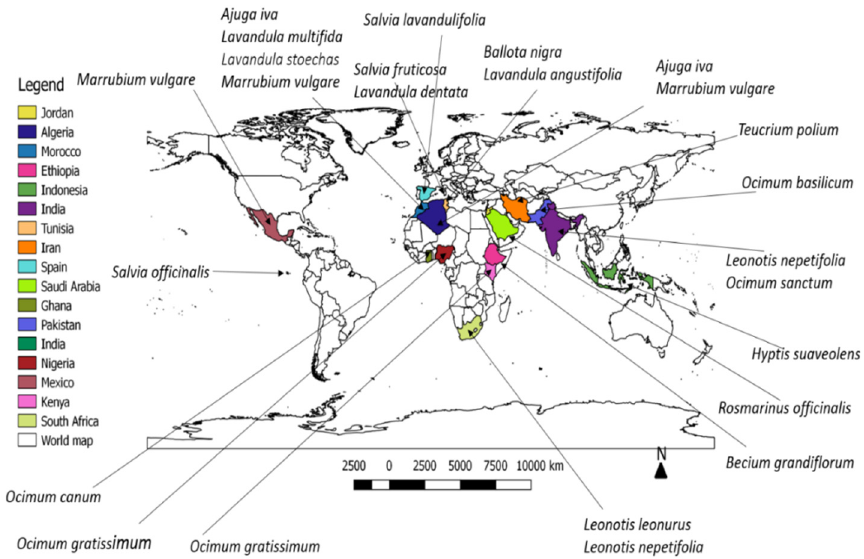
Figure 1. Plants species in the Lamiaceae family that are traditionally used to treat diabetes in different countries.